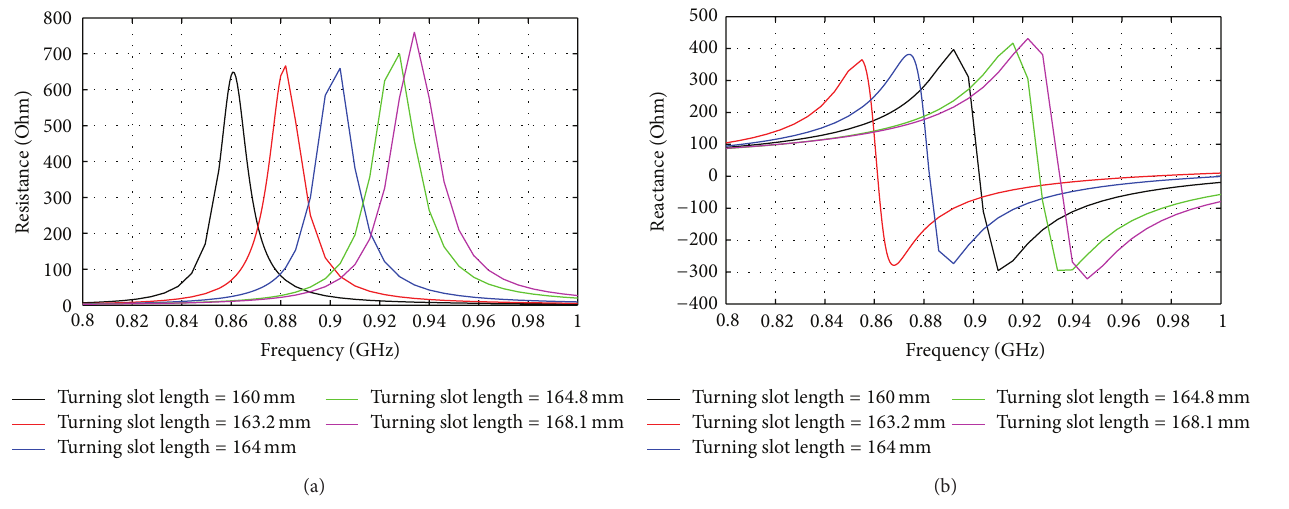
Figure 13: Tuning the real and imaginary parts of the input impedance by varying the tuning slot length.